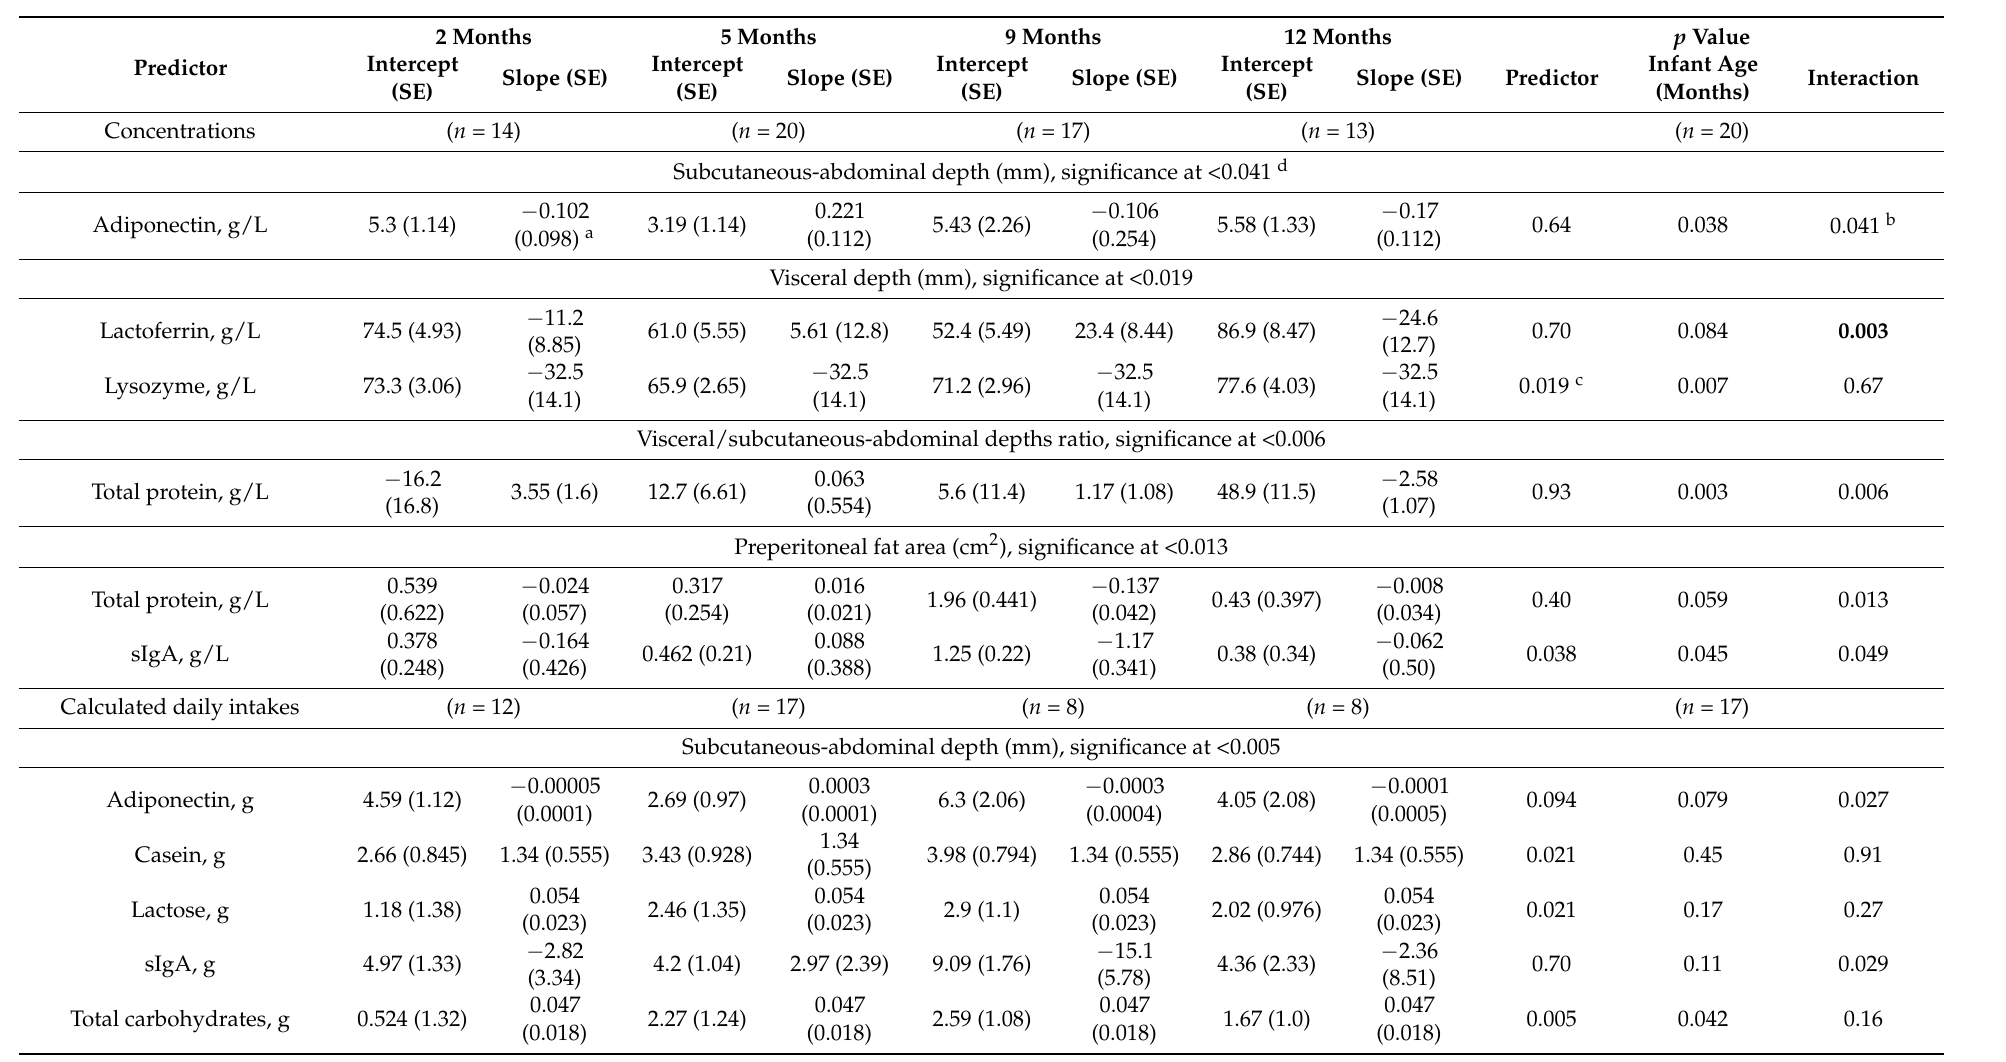
Table 2. Associations between infant abdominal adiposity parameters and concentrations and daily intakes of human milk